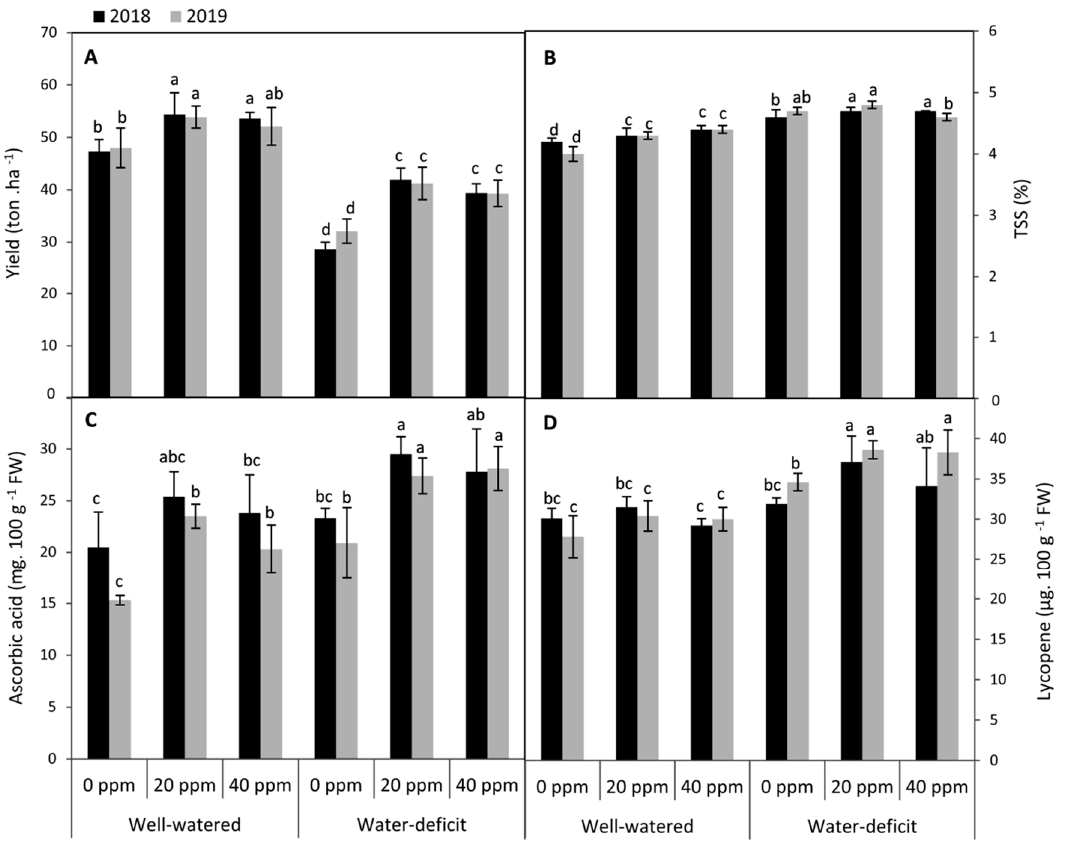
Figure 5. Effect of foliar application of d melatonin (MT) at 0, 20 and 40 ppm on (A) fruit yield, (B) total soluble solids (TSS), (C) ascorbic acid and (D) lycopene of tomato plants grown under well-watered and water deficit conditions in the seasons of 2018 and 2019. Means of three replicates were presented ±SD. Different letters are significant differences, according to Duncan’s multiple range tests ( p < 0.05).